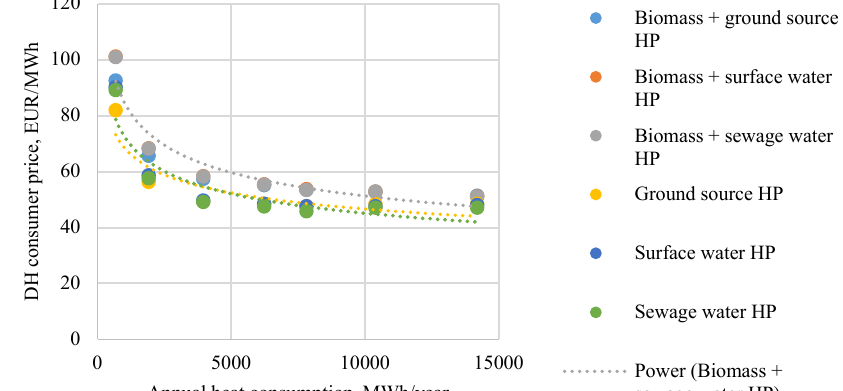
Fig. 7. DH consumer price relationship to DH annual heat